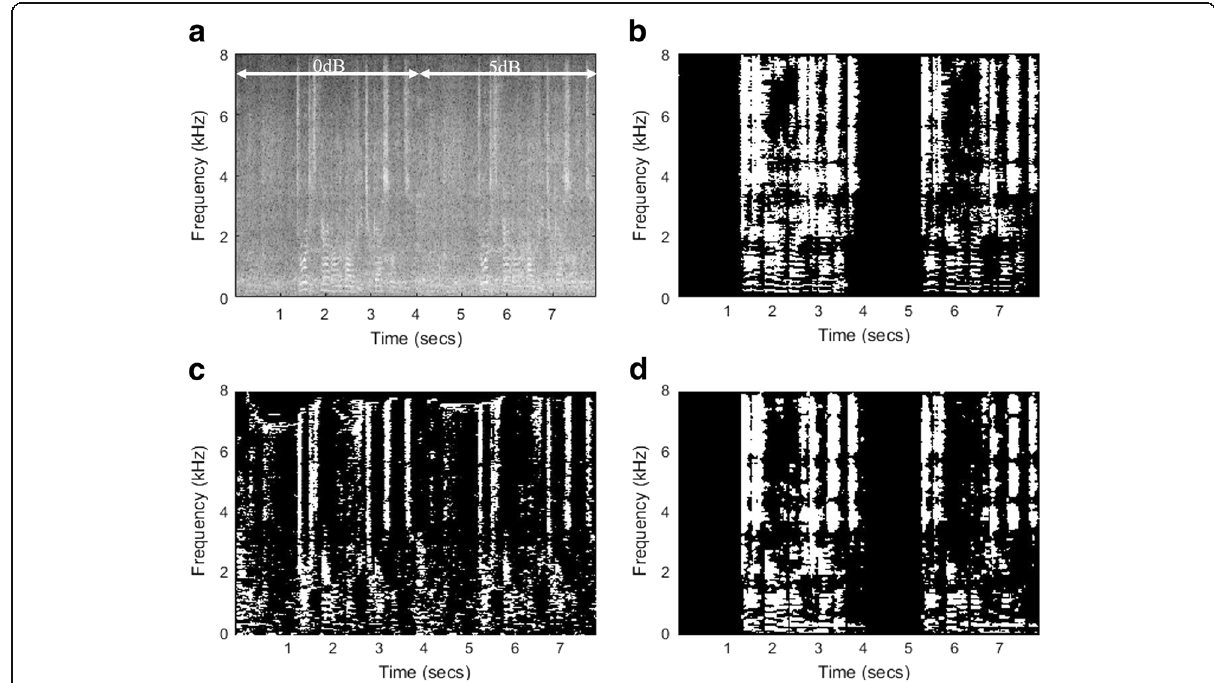
Fig. 7 a The spectrogram of the noisy input signal. The reference SPP maskers obtained using the b reference, c conventional, and d proposed